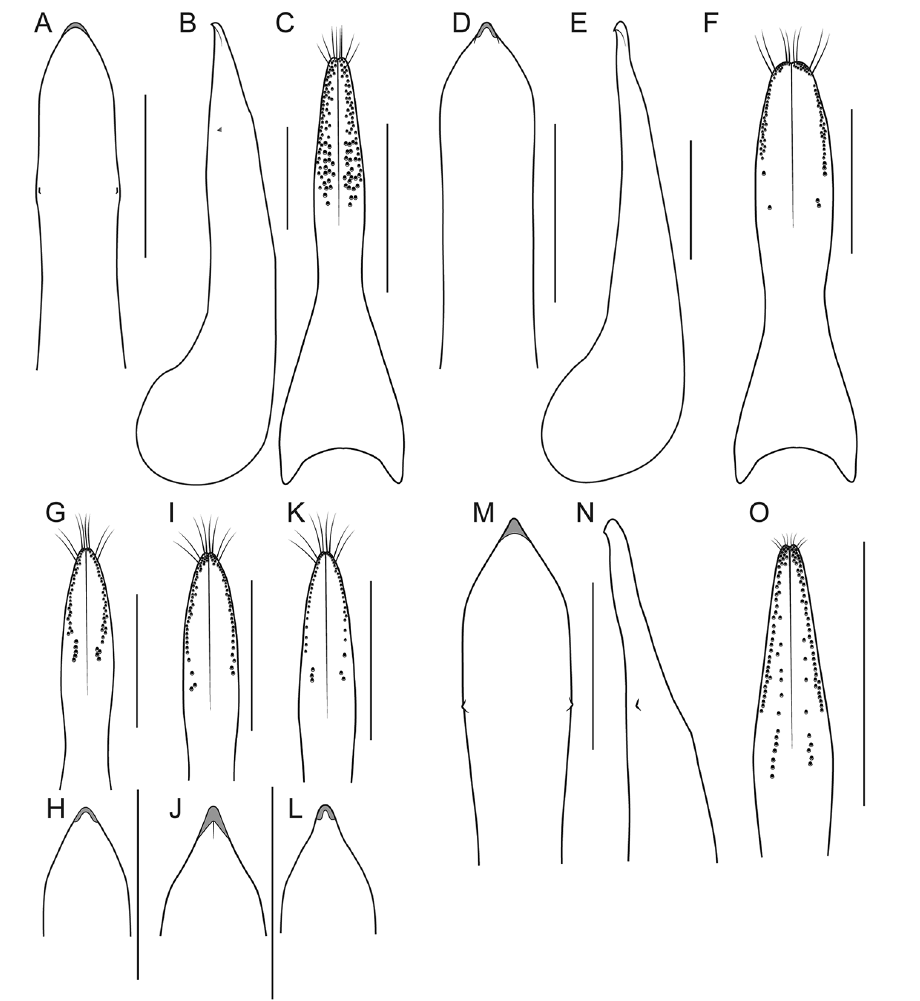
Figure 17. Bolitogyrus mulayitensis Brunke ( A–C ), B. smetanai Brunke ( D–F ), B. khasiensis Brunke ( G–H ), B. himalayicus Brunke ( I–J ), B. nanus Brunke ( K–L ), and B. pecki Brunke ( M–O ). Median lobe in parameral view ( A, D, H, J, L, M ), median lobe in lateral view ( B, E, N ), peg setae of paramere ( C, F, G, I, K, O ). Scale bars: 0.5